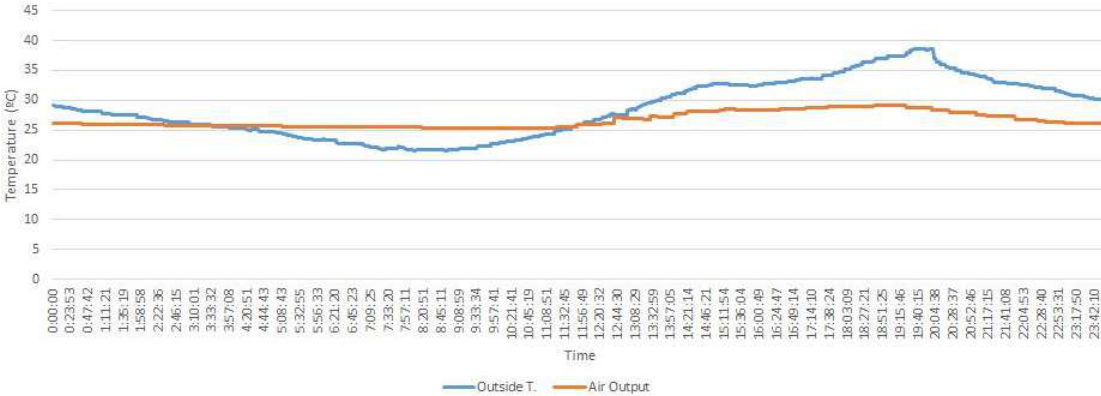
Figure 23. Daily variation in the outside air temperature and the output of the LEGE system for August 4, 2015.